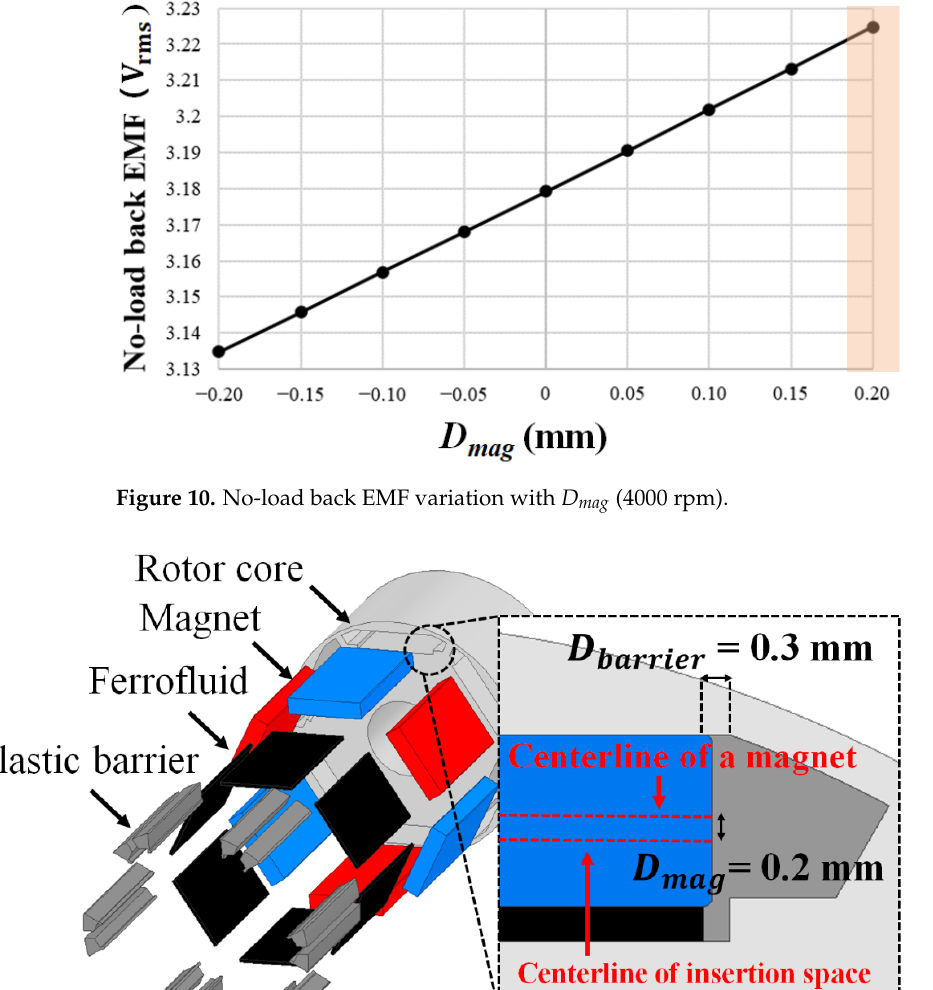
Figure 11. Rotor of the proposed model.